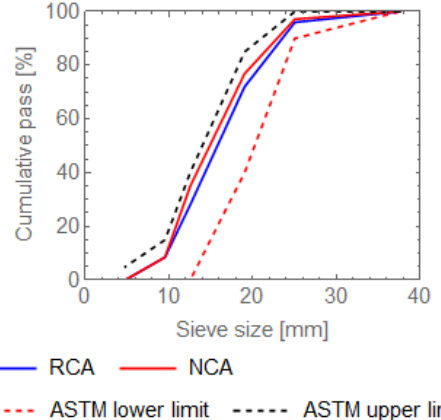
Figure 1. Aggregate size distribution of normal and recycled